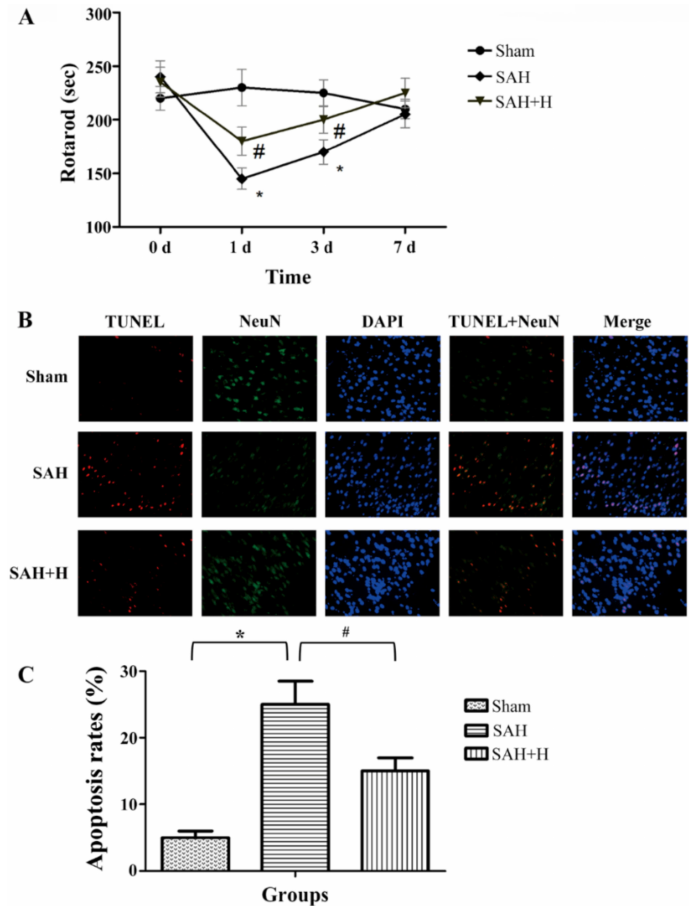
Figure 2. The rotarod and TUNEL staining. Rotarod test results ( A ) and TUNEL staining images ( B ) of the temporal cortexes for the indicated treatment groups ( × 400) 1 d after SAH induction. Panel ( C ) represents the apoptosis rates derived from the TUNEL assays. * p < 0.05 SAH vs. Sham, # p < 0.05 SAH vs. SAH +